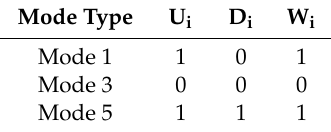
Table 5. The values of U, D, and W matrices, corresponding to operating modes of the